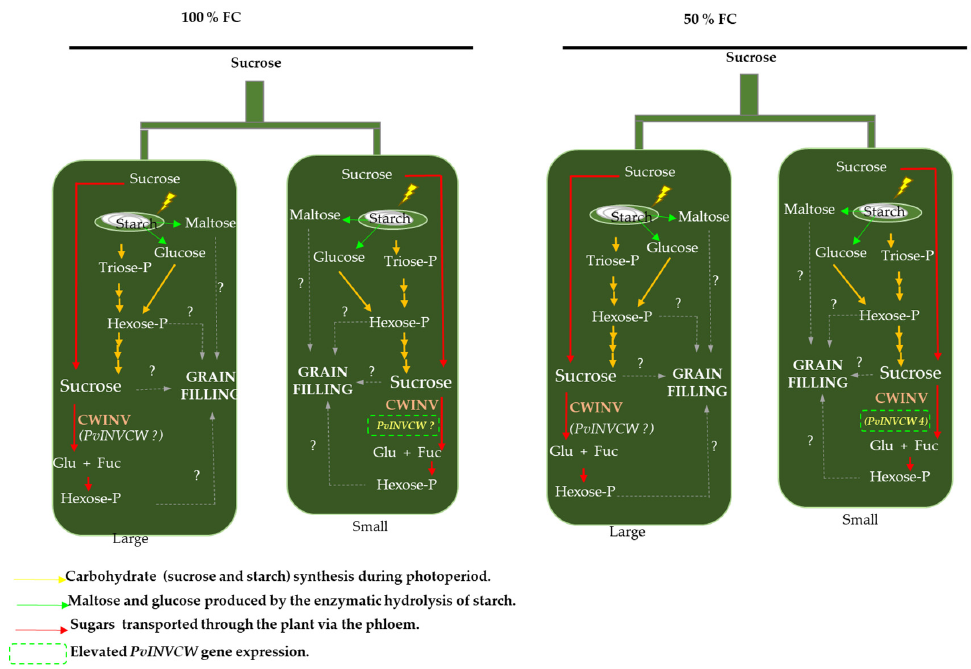
Figure 8. Representative model showing multiple pathways of carbon metabolism during grain filling in racemes at 100% FC and 50% FC. First, the pod wall could perform photosynthesis for starch and sucrose synthesis. Second, products of starch hydrolysis (maltose and hexose) could be used for carbon metabolism in seeds. Third, sucrose could be transported to the peduncle and distributed in large and small pods via funicule to seed. Then, it is degraded by cell wall invertase (INVCW), and hexoses are probably used for grain filling. The activity of INVCW increased in the walls of small pods independent of the water regime, but fructose levels decreased in the walls of large and small pods under water restriction. The mRNA transcript levels of the PvINVCW4 gene were consistent with high enzymatic activity in small pericarps at 50% FC, but this increase was not mimicked in walls of large pods. These findings suggest that an additional isoform of INVCW could participate in sucrose